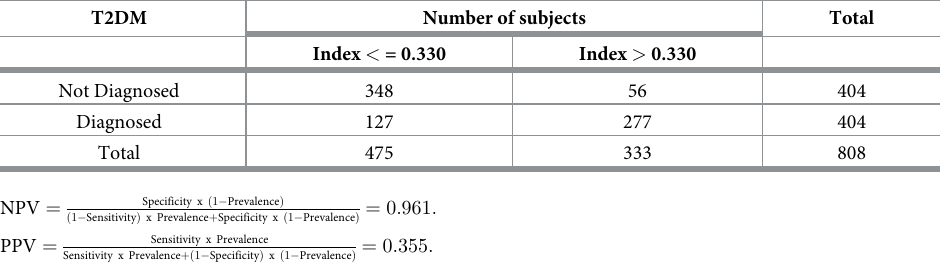
Table 3. Number of subjects of weighted coefficients of BMI, C1, C2 and C3 (Cut point = 0.330, p < 0.001) with and without T2DM.